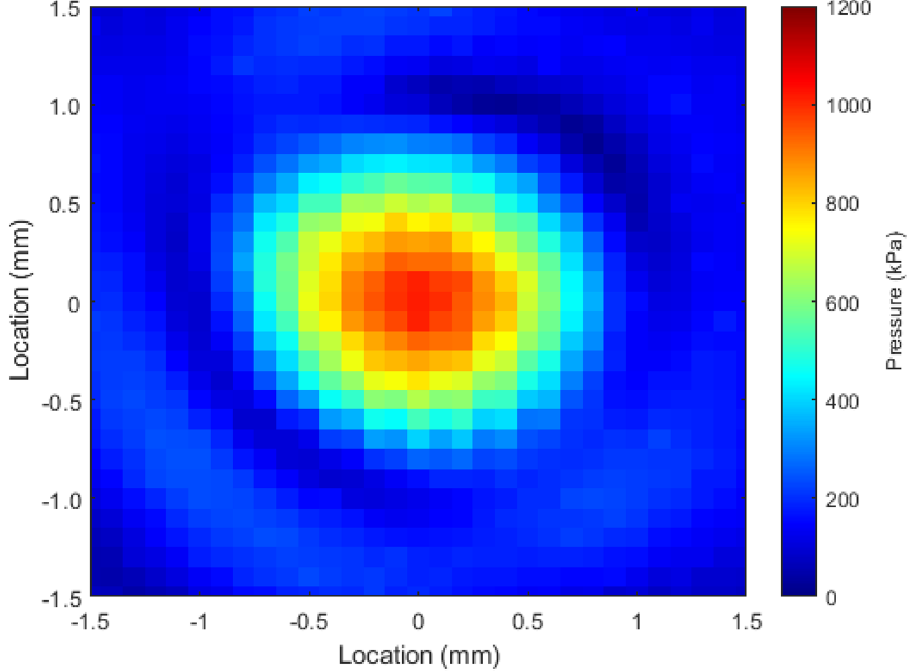
Figure 5. Surface plot of the pressure distribution of a focussed ultrasound transducer operated at 10